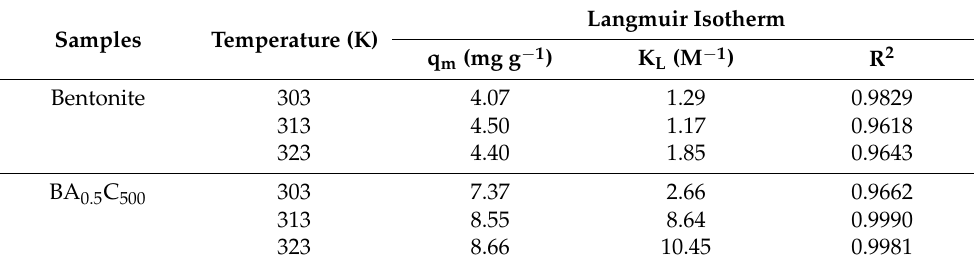
Table 11. Parameters for adsorption of 2,4-D on bentonite and BA 0.5 C 500 .